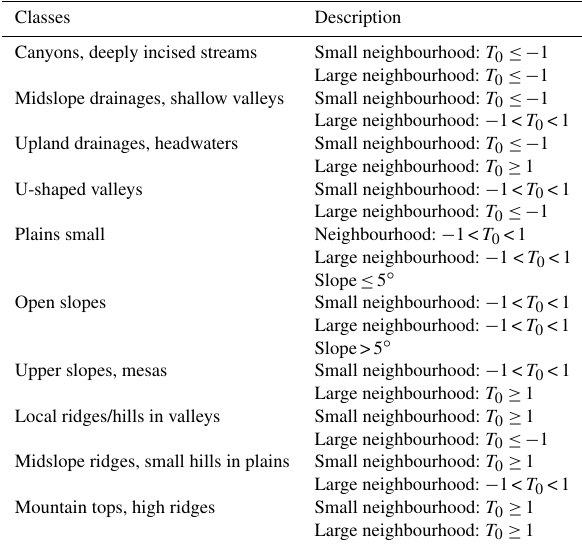
Table 3. Landform classification based on TPI (source: Weiss, 2006).